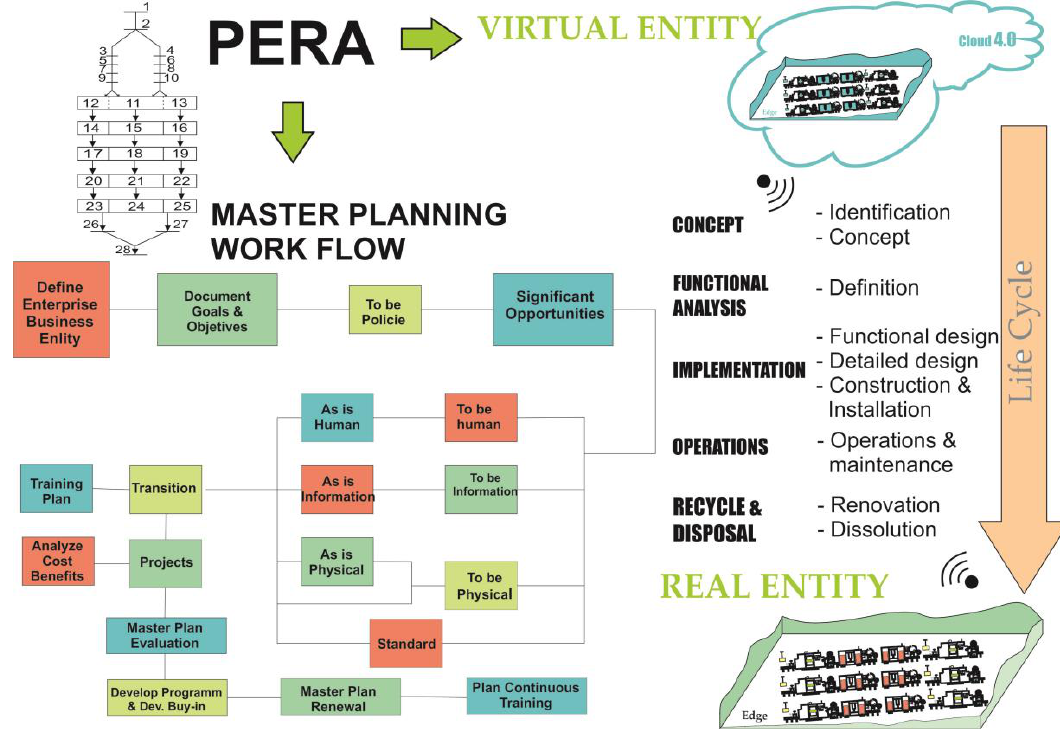
Figure 9. Basic methodology of a PERA 4.0 entity.